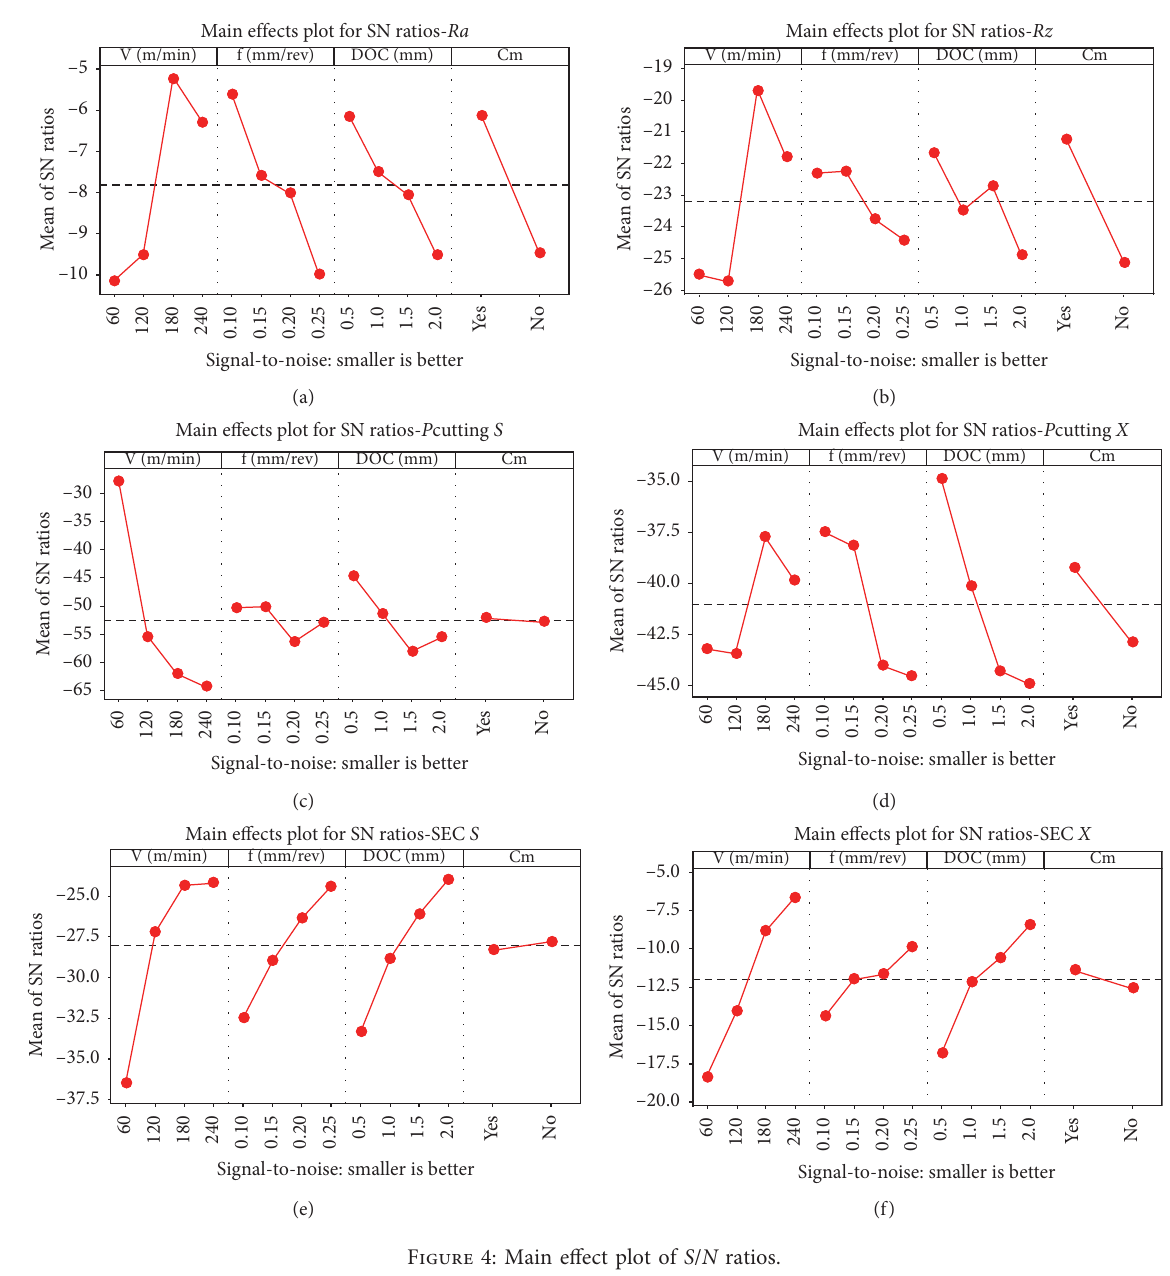
Figure 4: Main effect plot of S / N